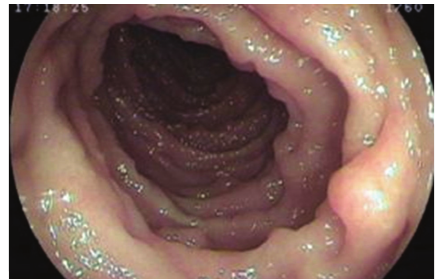
Figure 5: Polyposis in stomach.